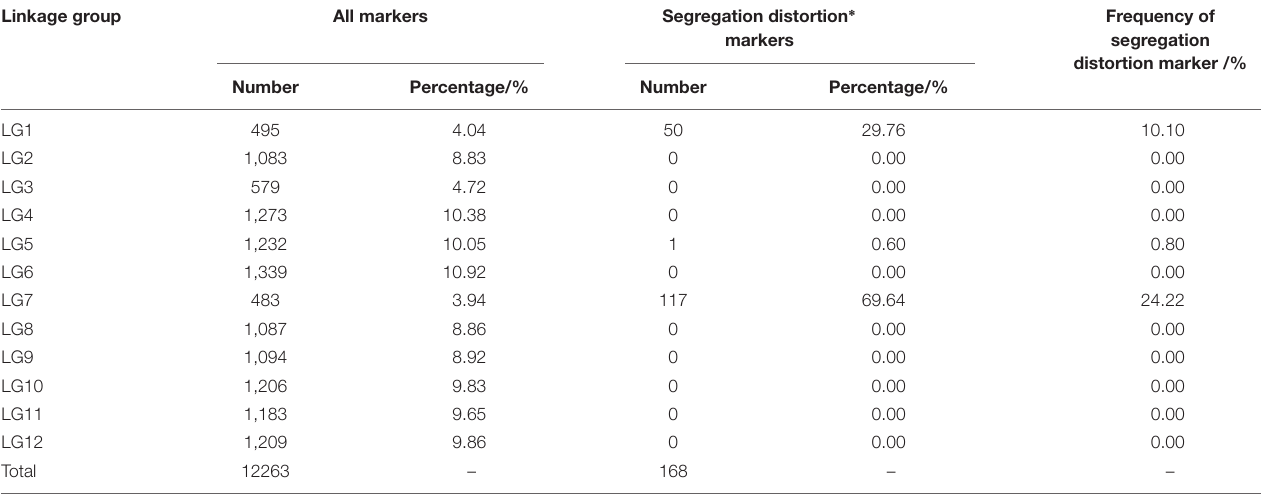
TABLE 4 | Distribution of segregation distortion markers. Linkage